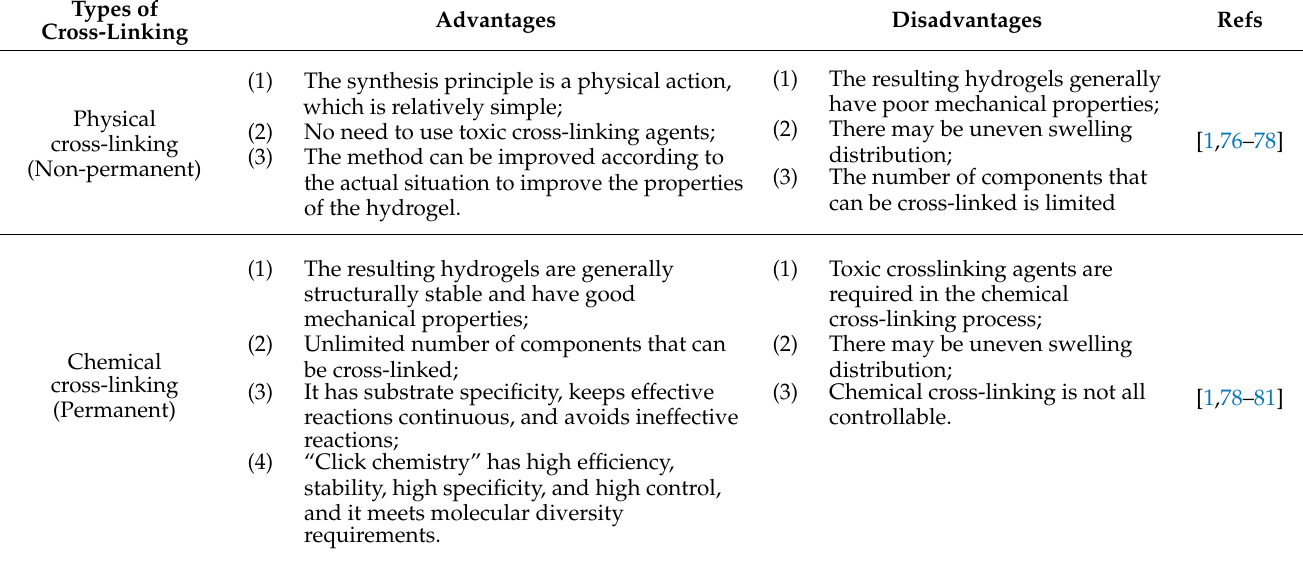
Table 2. Advantages and disadvantages of physical cross-linking and chemical cross-linking technology. Types of Advantages Disadvantages Cross-Linking